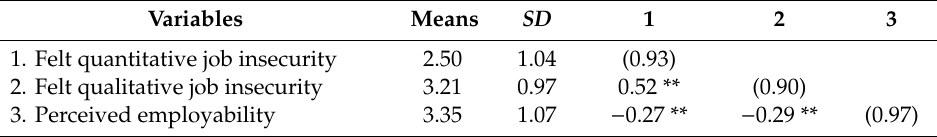
Table 1. Means, standard deviations and correlations for the study variables of Sample 1.